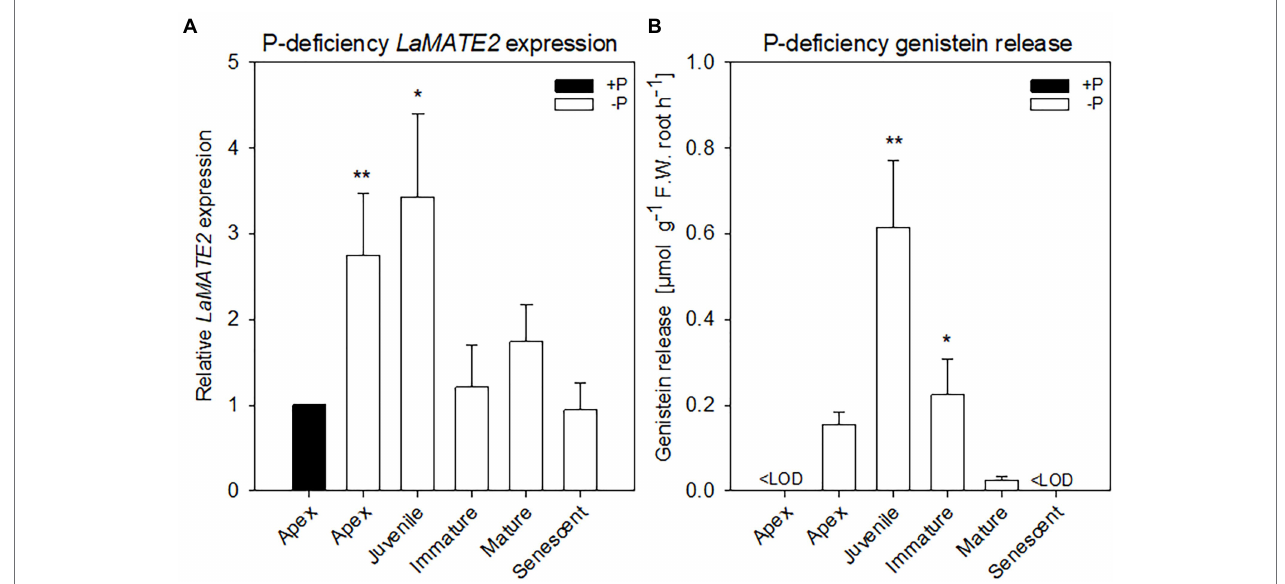
FIGURE 1 | LaMATE2 expression level and genistein release in roots of P-deficient white lupin. LaMATE2 expression analyses in white lupin grown under control (+N + P, black bars) condition or P deficiency (+N-P, white bars) (A) . Gene expression was evaluated in control apex (+N + P), P-deficient apex and cluster roots (separated depending on developing stages: Juvenile, Immature, Mature, Senescent cluster-root stages; example of cluster root shown in Supplementary Figure S1 ). Expression levels are shown relative to the LaMATE2 expression level of the root apex under control conditions (+N + P). Release of genistein from different root tissues of 4-week-old P-deficient plants, release from the control apex was below detectable value <LOD (B) . Data are mean + SD (Asterisks refer to statistically significant differences among the mean value of the sample vs control or -P apex for genistein release, ANOVA Holm–Sidak, N = 6, * p < 0.05, ** p < 0.01; with 3 technical replicates for each real-time